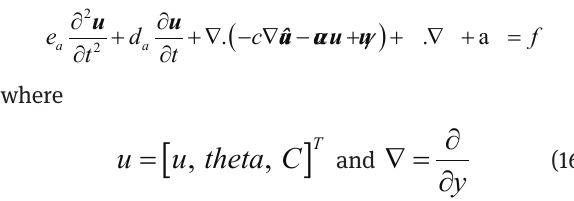
Fig. 2 represents the velocity profile for different values of time. In the problem, the plate is moving and the magnetic field is applied in the transverse direction. The Reynolds number is taken to be very small to keep the flow laminar. It is clear from Fig. 2 that on increasing the values of time, the velocity decreases. At 0.25 t = , there is an effect of the moving plate on the velocity and, after certain time, its effects decrease, resulting in the velocity of the fluid decreasing. Fig. 3 indicates the temperature profiles for different values of time. Due to MHD free convection in the fluid, heat is transferred through fluid flow. For increasing values of time, the temperatures in the flow also decrease.